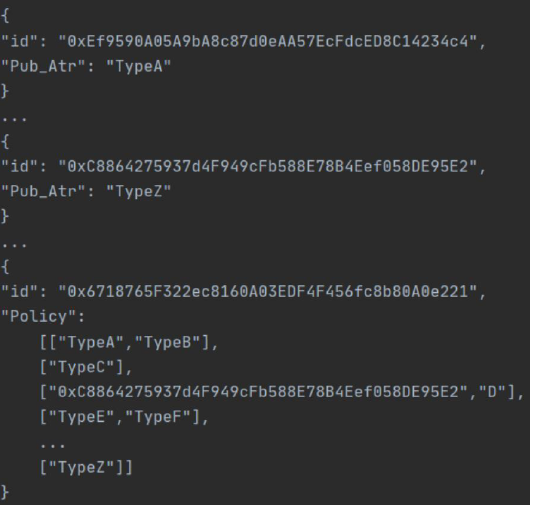
Figure 5. The data formart of LD ’s public attribute and LP ’s policy recorded in the